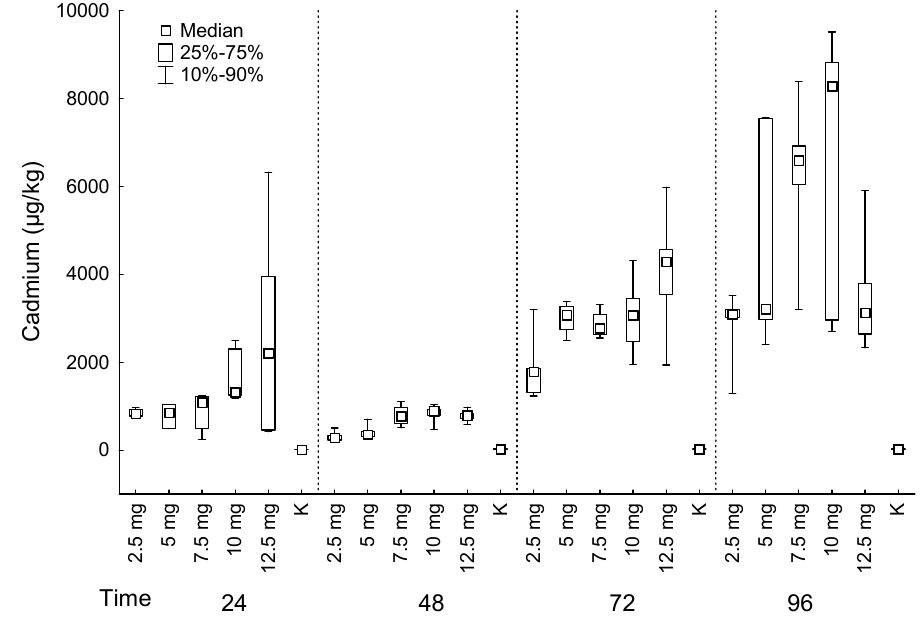
Figure 2 . LIVER: Cadmium ( μ g/kg) in fish grouped according the exposition to cadmium chloride (mg/L) (K–control